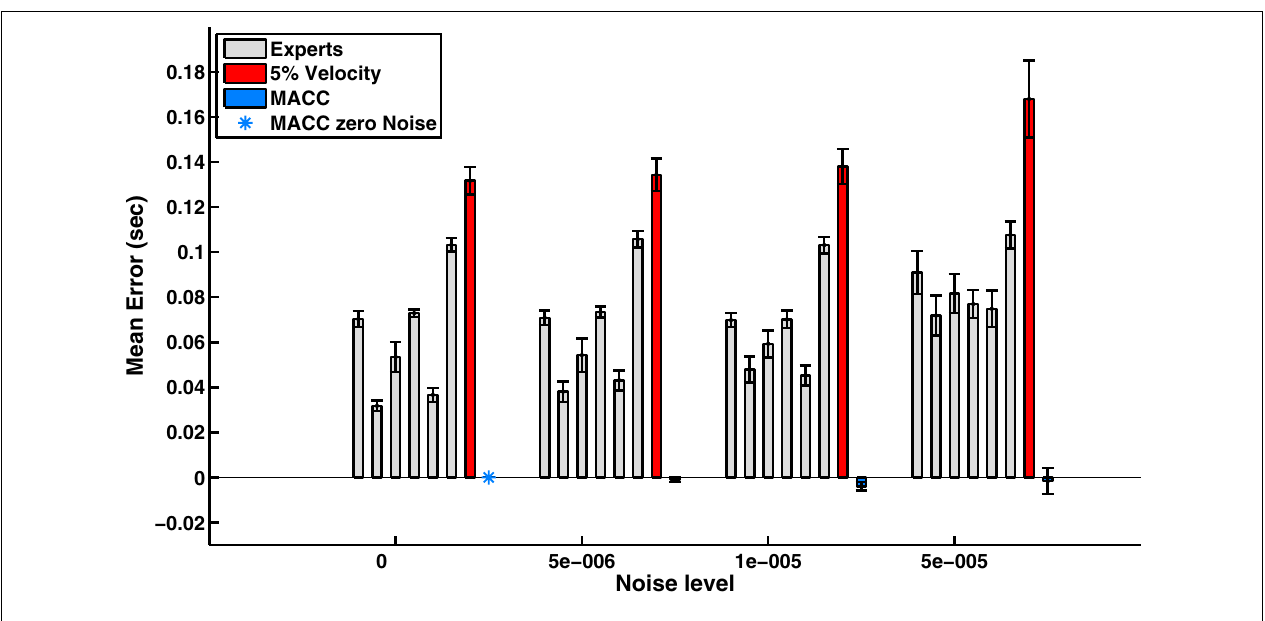
FIGURE 3 | Mean onset error presenting the accuracy of the MACC onset detection method over manual onset detection by experts and automatic velocity-based onset detection. Bar represents mean value and error bar